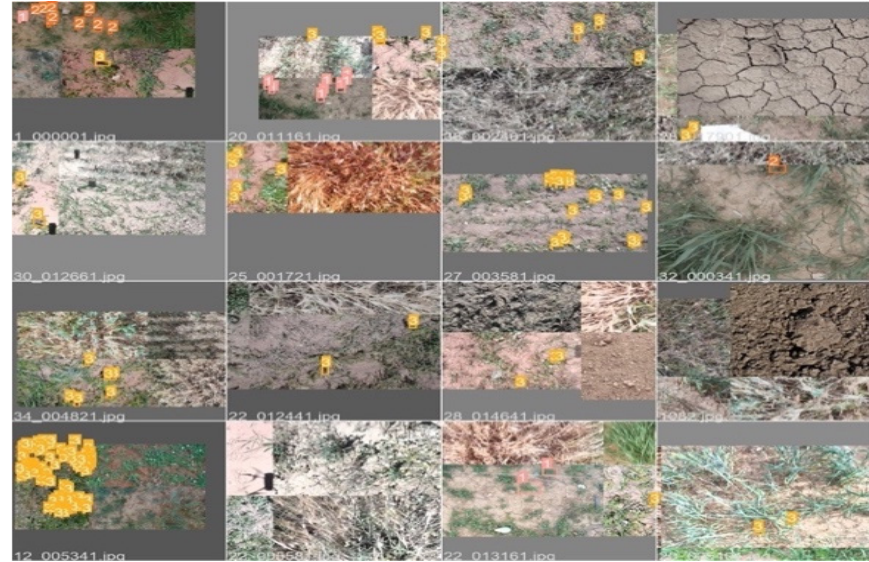
Figure 2. Mosaic